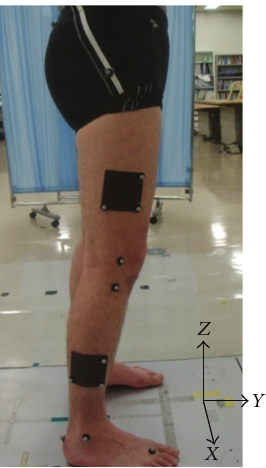
Figure 3: Rigid plates (black squares) with three reflective markers were attached to the thigh and